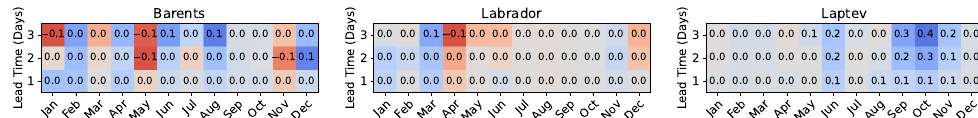
Figure 9. JAXA SIC MAE averaged over 3 days of forecast and over 2021 (lower is better) for baselines and different configurations of U-Net. Colors denote model groups (baselines, U-Net (S), and U-Net (R)), configuration of each model within a group is specified below each bar. For U-Net regional and general configurations were trained with or without GFS. The best configurations from each group are presented separately on the right of each region plot for comparison.